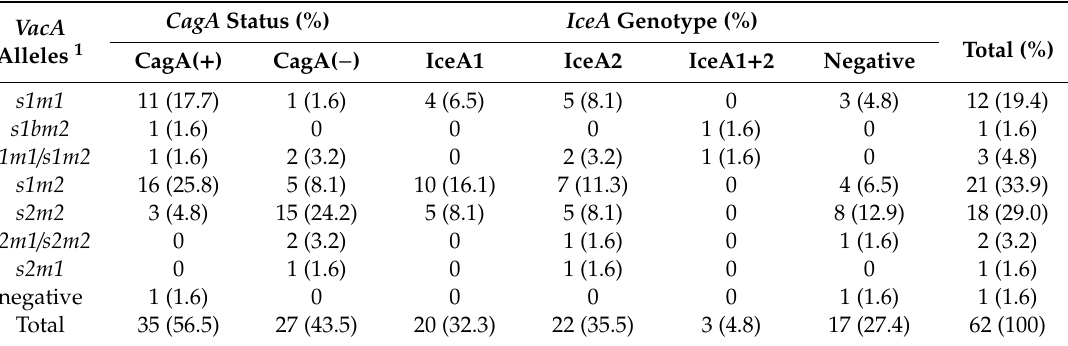
Table 2. Distribution of H. pylori vacA genes / alleles according to cagA and iceA status. VacA